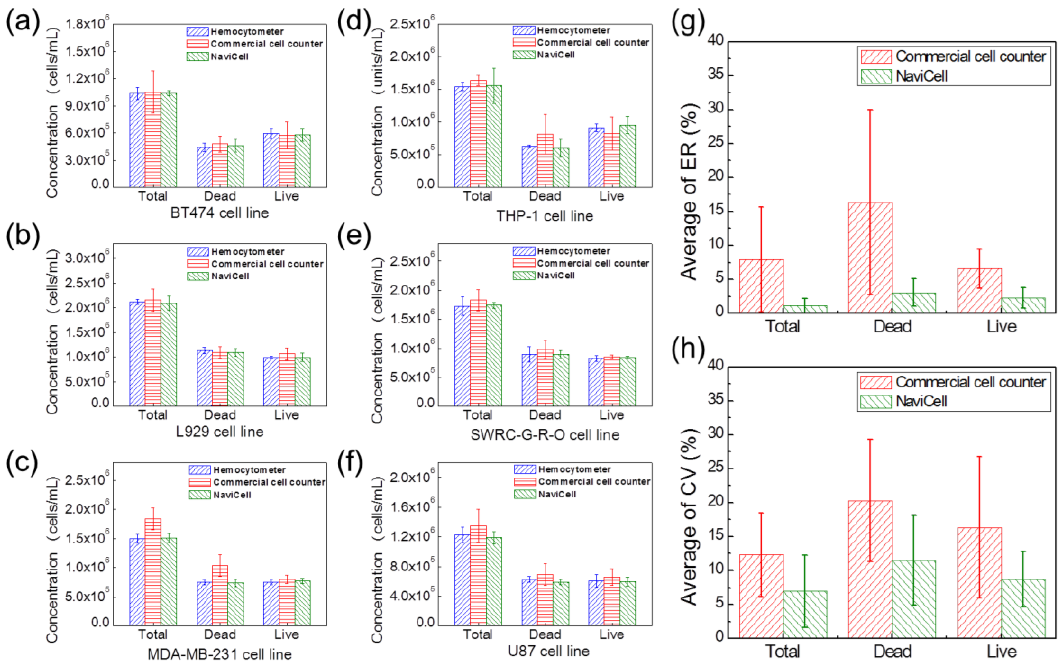
Figure 6. Comparison of cell viability performance using six cell lines. ( a – f ) Concentrations of BT474, L929, MDA-MB-231, THP-1, SWRC-G-R-O and U87 cell lines, respectively, by dividing